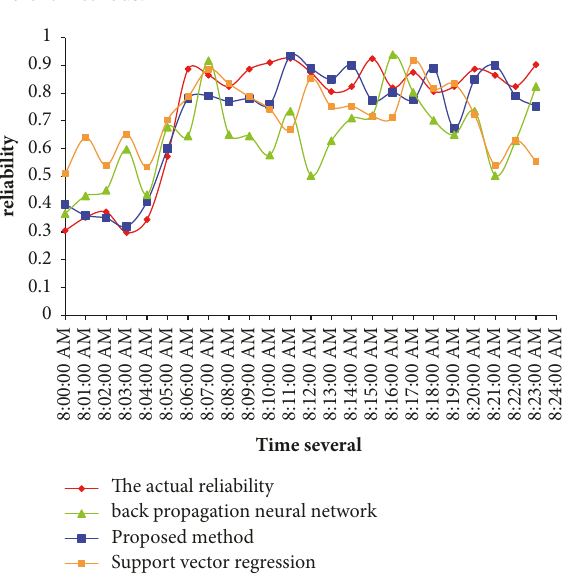
Figure 11: Multistep prediction of weekday reliability based on different methods.